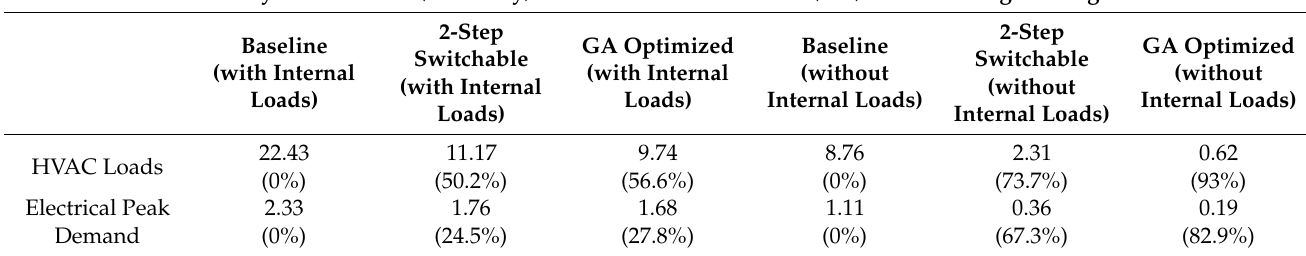
Table 14. HVAC loads and electrical peak demand for baseline windows and STIS–smart windows applied to a house in Golden, CO, USA—with and without internal